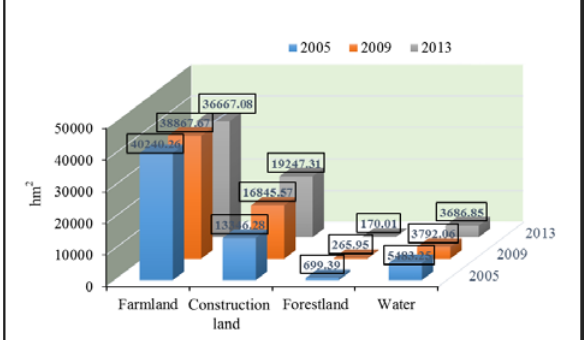
Figure 3. Characteristics of landscape types in Panji District.